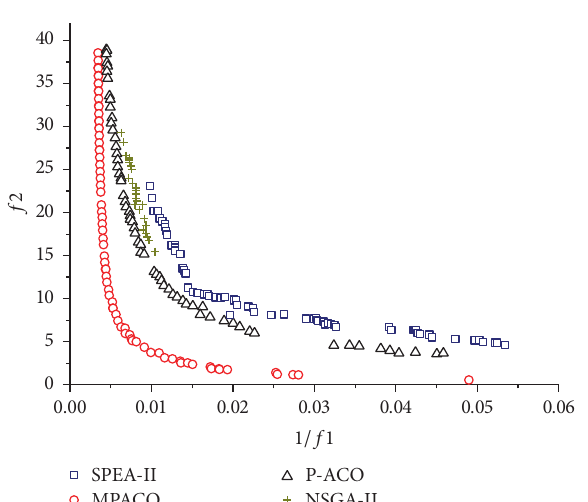
Figure 6: Plots of PSs best performance in 30 runs of four algorithms on Scale 2 .